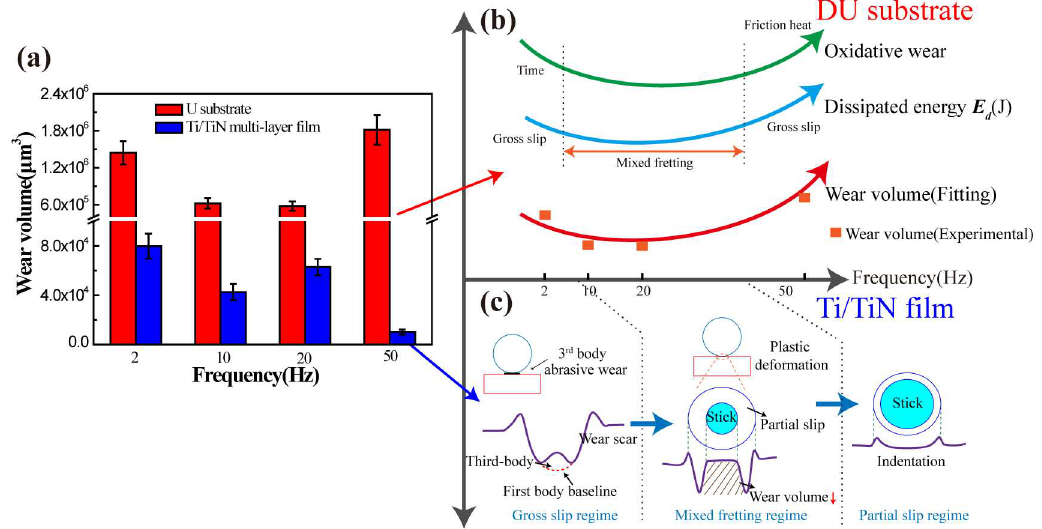
Fig 9. The wear volume of DU substrate and Ti/TiN multi-layer film (a), and the schematic diagram to explain the wear volume of DU (b) and Ti/TiN multi-layer film (c).